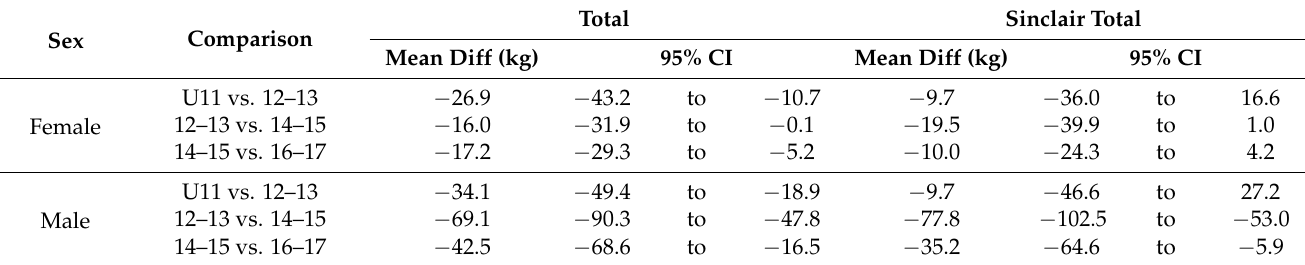
Table 2. Mean differences between age groups within a